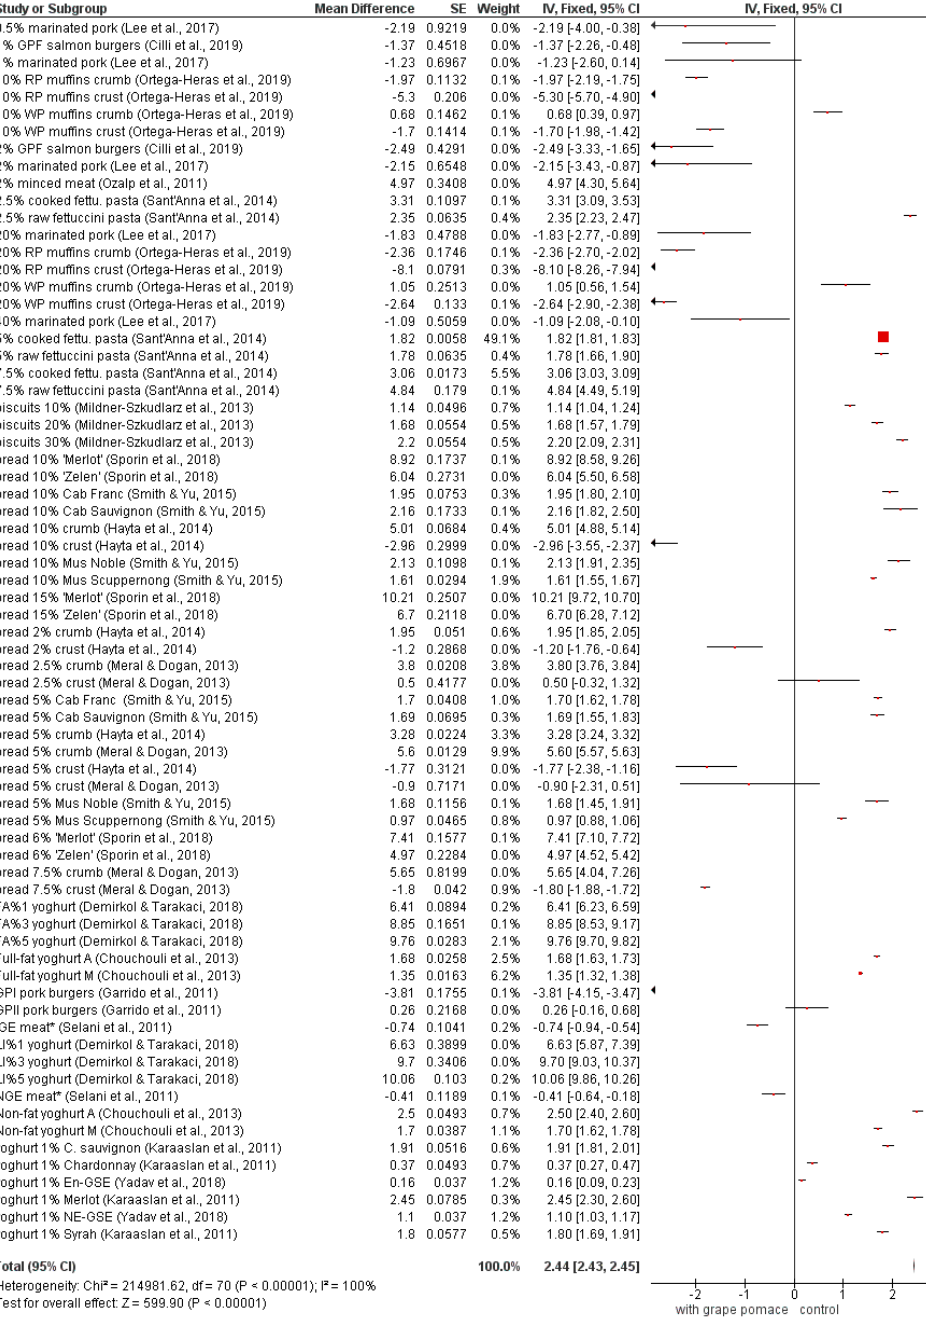
Figure 4. Meta-analysis of a value in fortified products [13,19,21,23,43,46,47,53,60,63,64,69,70,72,73]; * En-GSE—encapsulated grape seed extract in yoghurt; NE-GSE—nonencapsulated grape seed extract in yoghurt; RP—red grape pomace; WP—white grape pomace; GPF—grape pomace flour; FA—forced air-dried grape pomace; LI—lyophilized grape pomace; A—Agiorgitiko seed extracts; M—Moschofilero seed extracts; GPI—grape pomace extract Type I (high-low instantaneous pressure (HLIP) + methanolic extraction); GPII—Grape pomace extract Type II (methanolic extraction; GPII); IGE—Isabel grape seed and peel extract; NGE—Niagara grape seed and peel